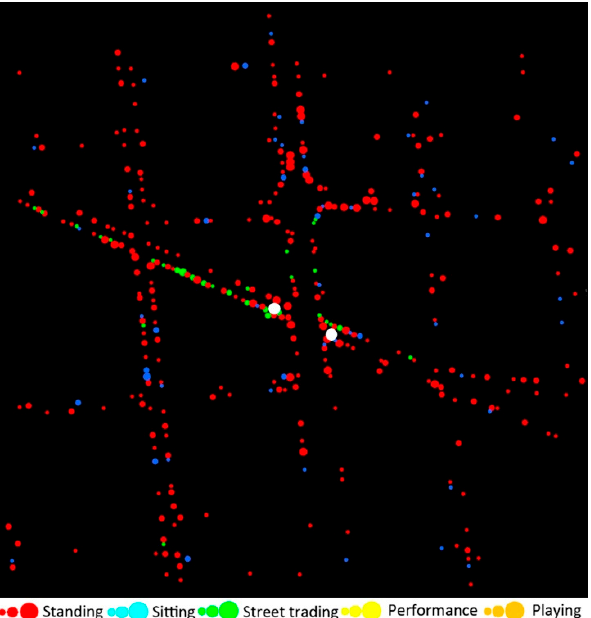
Figure 8. The mix of activities. The West: Navab. Scale: 1 km × 1 km. Map: Nastaran Peimani.